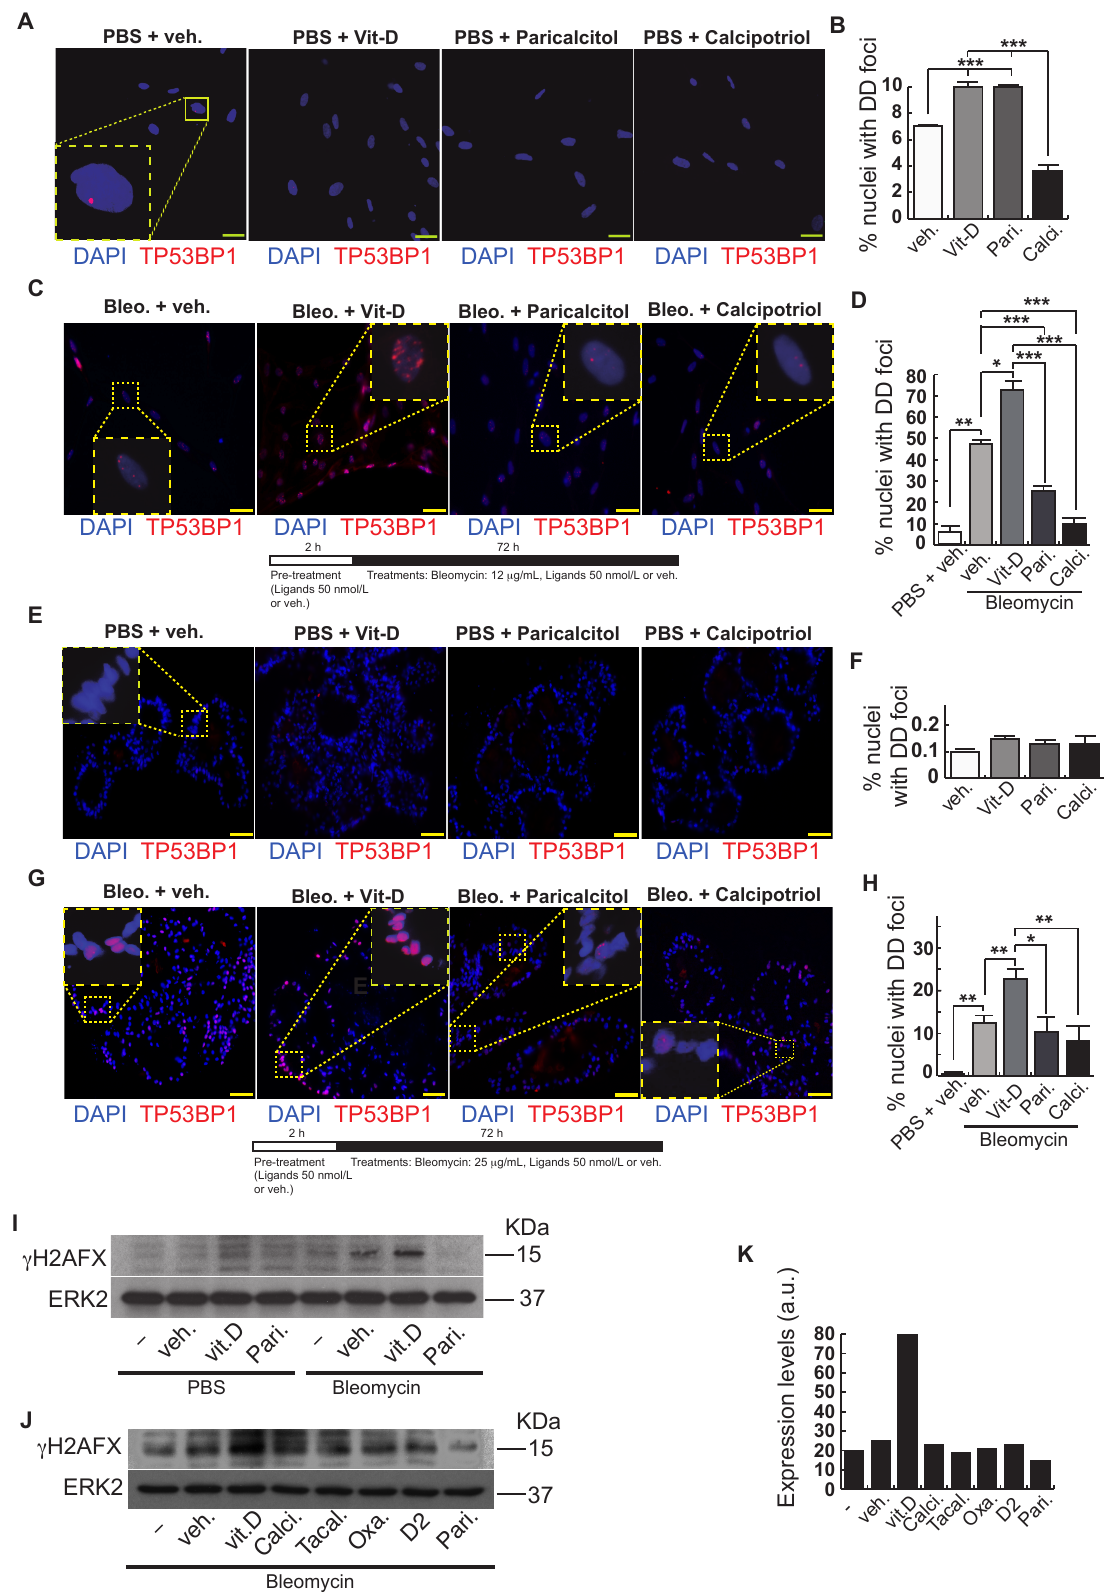
Figure 4. Effects of vitamin D and hypocalcemic analogs in the expression of DNA damage induced by bleomycin in the minilungs generated from hESCs. ( A ) Basal expression of DNA damage (TP53BP1 foci (red dots)) induced by vitamin D and the analogs paricalcitol and calcipotriol in the absence